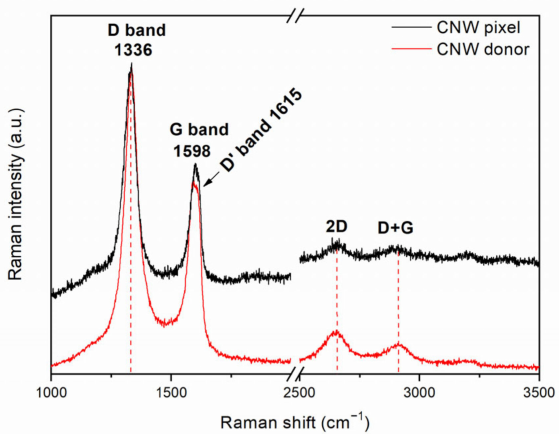
Figure 4. Raman spectra of a CNW donor prior to LIFT and a CNW pixel. In order to fabricate CNW-based sensors, we transferred CNW pixels at a 450 mJ/cm 2 laser fluence onto sensor pads and tested their sensing abilities towards different concentra- tions of ammonia. The transfers onto the IDT structure did not show significant differences from the transfers onto the polyimide flat substrates. An optical microscopy image of a CNW pixel transferred onto a sensor pad is shown in Figure 5a, while cross-section SEM images taken at a higher magnification of the CNW pixel printed onto the metal electrodes are shown in Figure 5b,c. After the transfer, the as-fabricated sensors were conditioned as described in the experimental section to cure the transferred material.